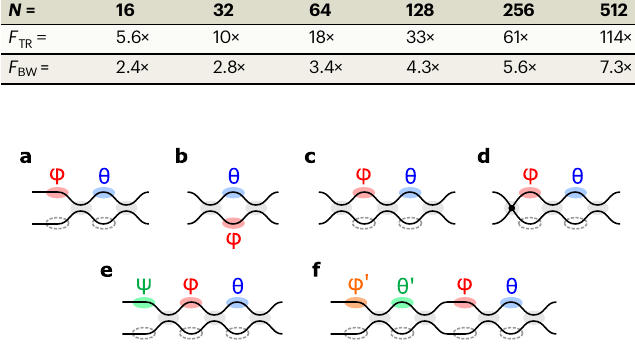
Fig. 8 | Comparison of crossing types. a MZI, b symmetric (S-MZI) 64 , c 3-splitter